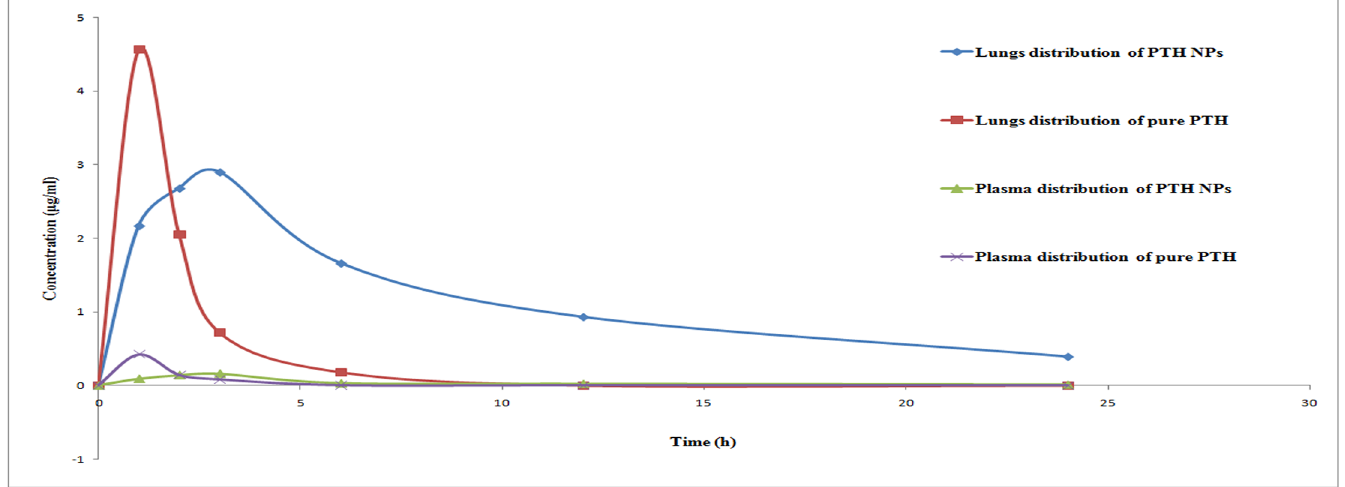
Fig 3. Bio-distribution of PTH in free and nanoparticles